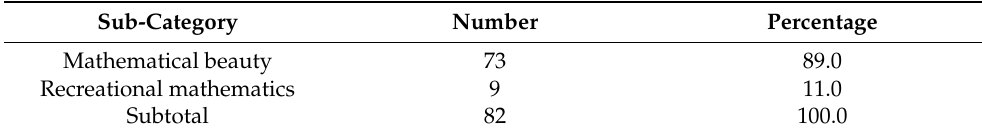
Table 6. The content distribution of the category of Aesthetics & Recreation .